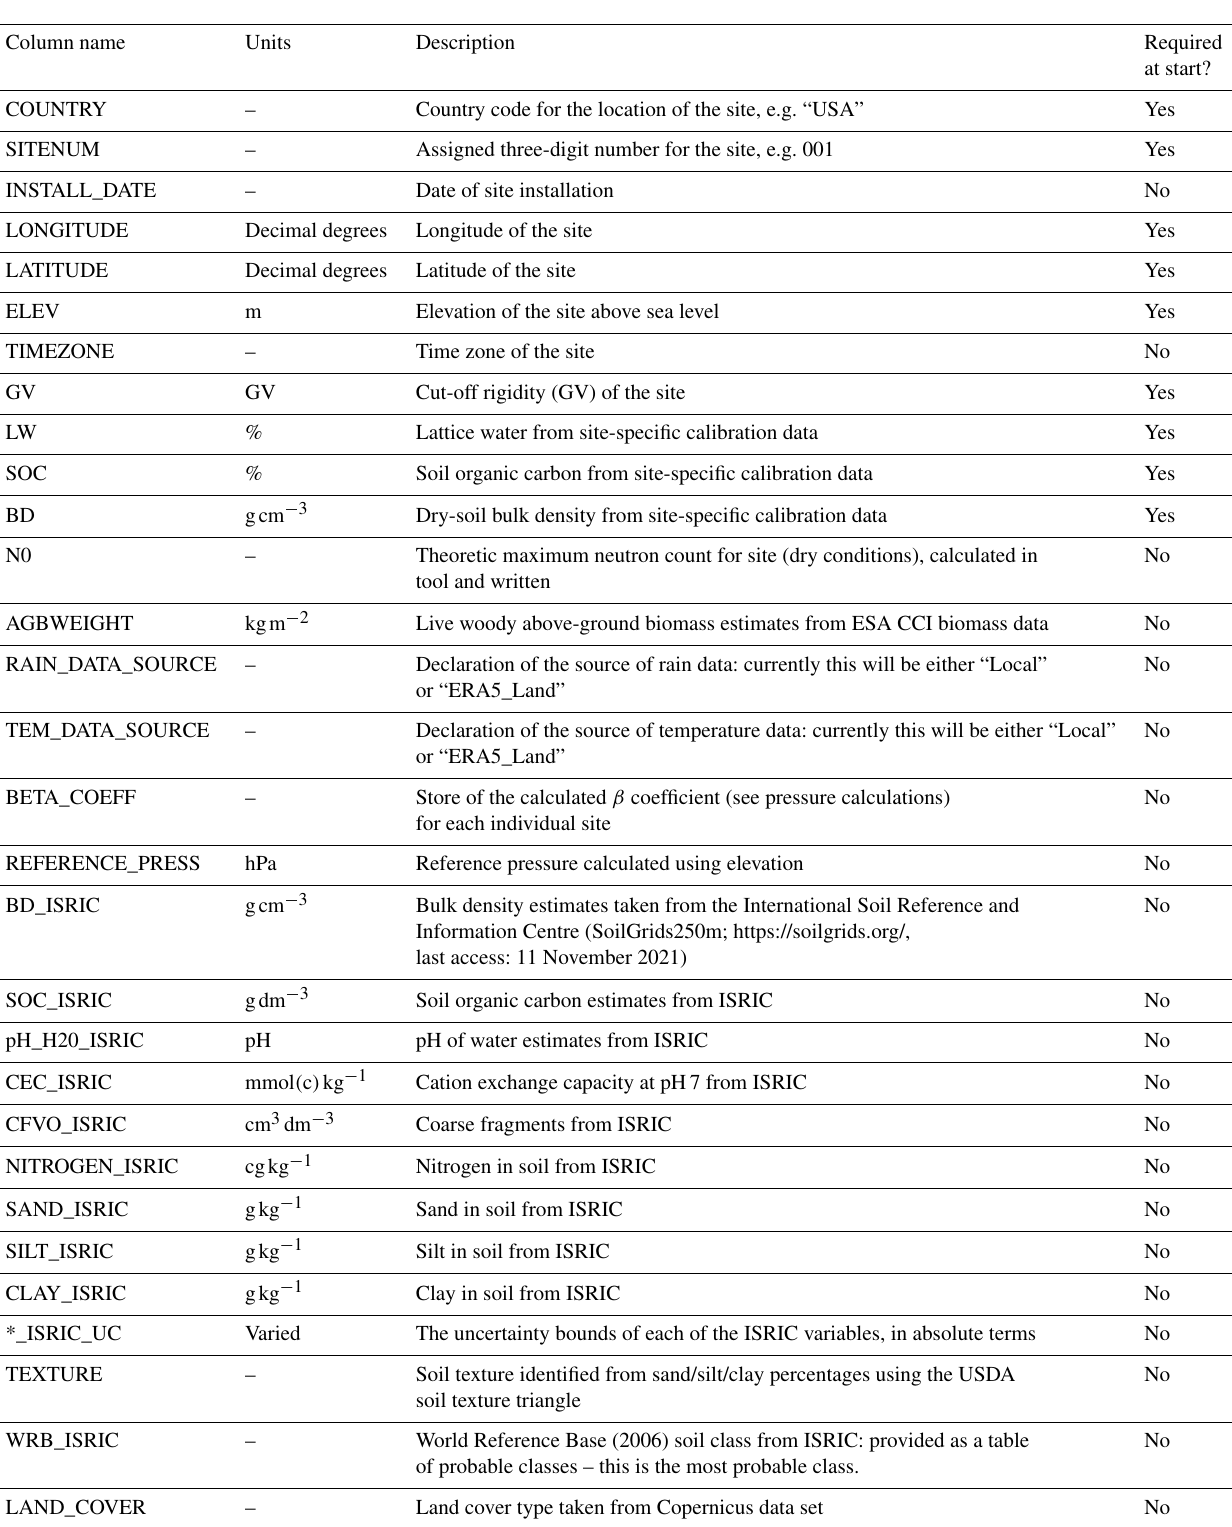
Table A3. The naming convention of the metadata table. Column name Units Description Required